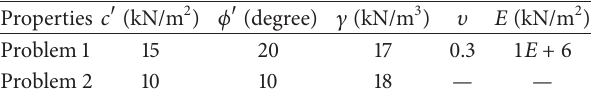
Table 4: Properties of slopes in example problems.